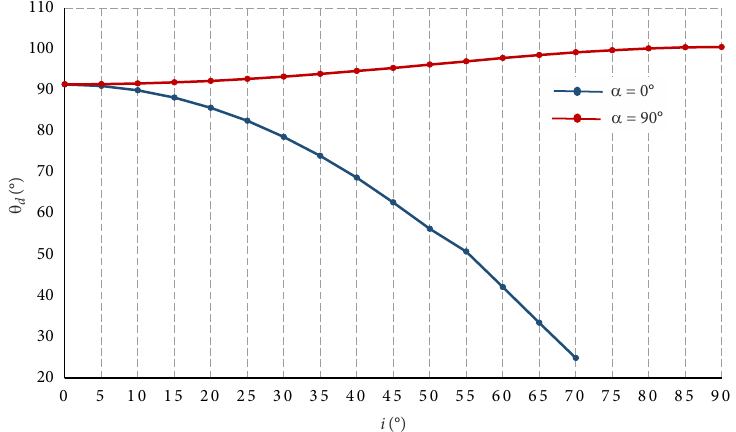
Figure 8. Failure width versus orientation angle for the strike-slip faulting stress